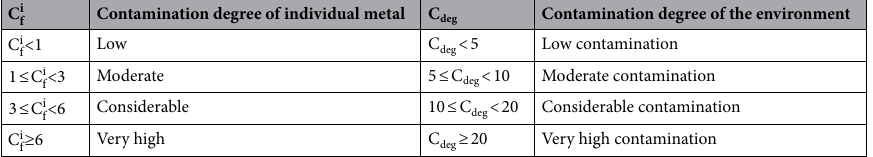
Table 5. Contamination factor ( C